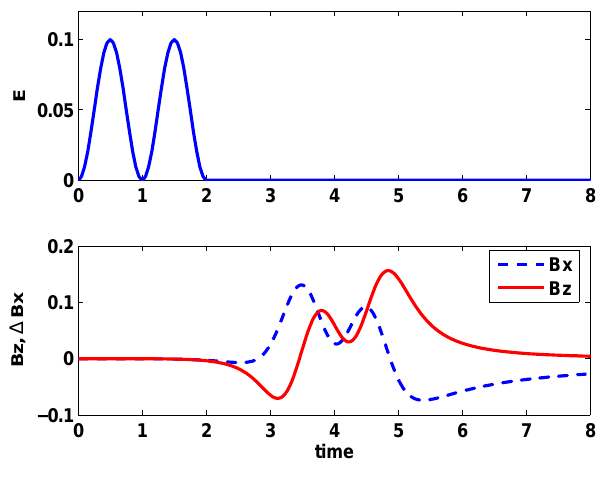
Fig. 2. Dual reconnection pulse (upper panel) and the correspond- ing magnetic field perturbations (lower panel).